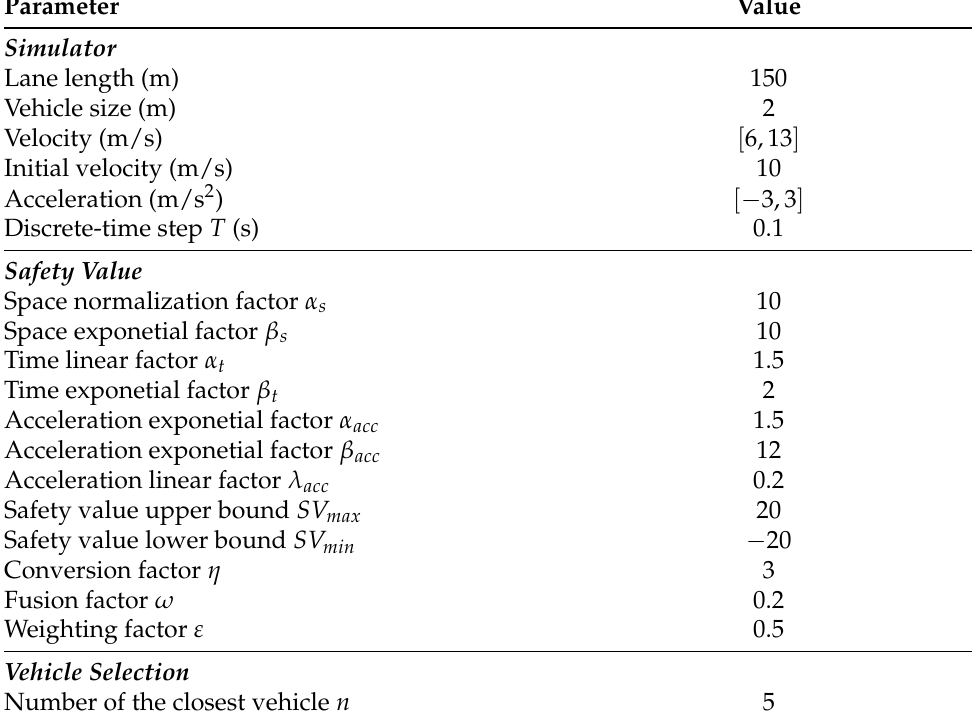
Table 1. Experimental